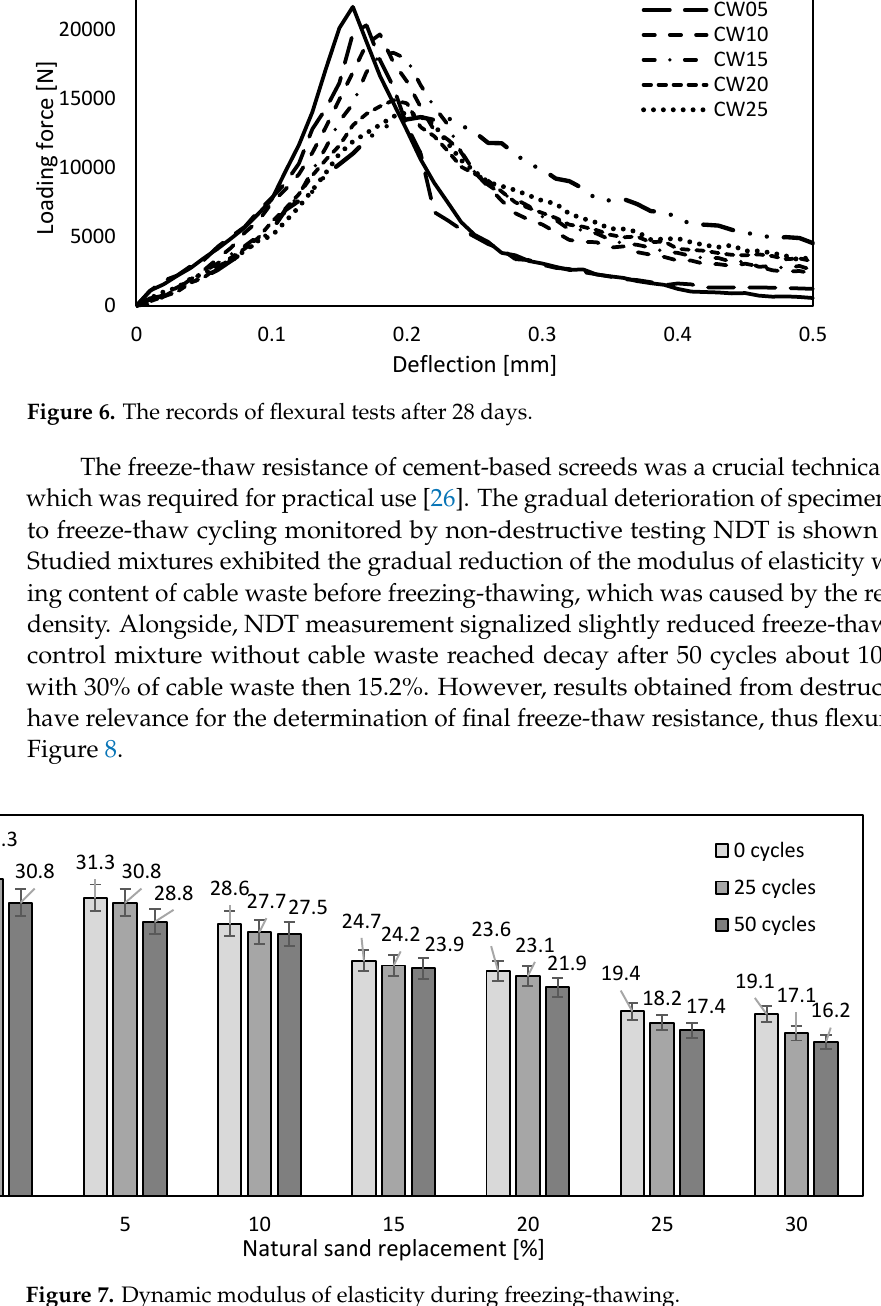
Figure 7. Dynamic modulus of elasticity during freezing-thawing.